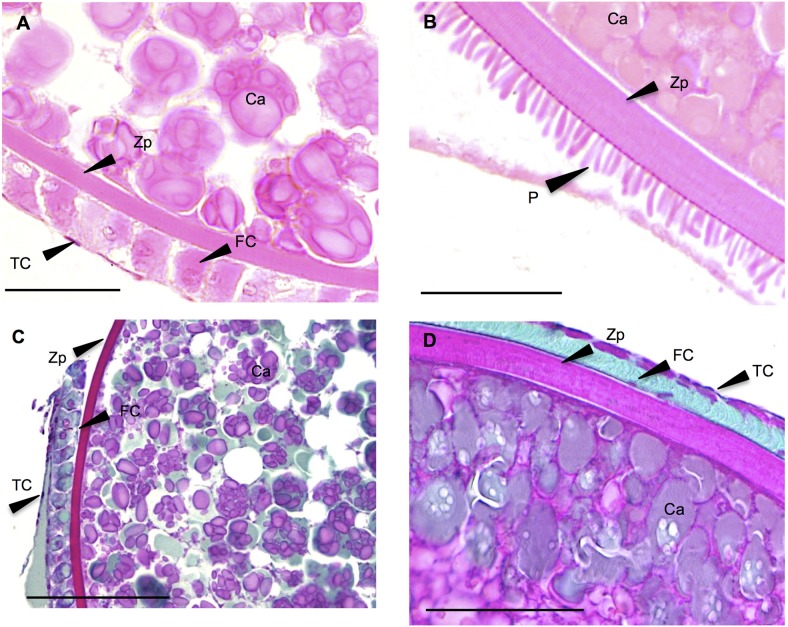
Vitellogenic follicles.
A–B: Vitellogenic follicles found in gonads of all-male rainbow trout testis at 136 dpf exposed chronically to 0.01 and 10 µg/L EE2 for 76 days. HES. Zp: Zona pellucida; FC: follicular cells (granulosa); TC: thecal cells; CA: cortical alveoli; P: protrusions probably originated from the follicular cells. C–D: Masson’s staining of a vitellogenic follicle. Scale bars 50 µm.